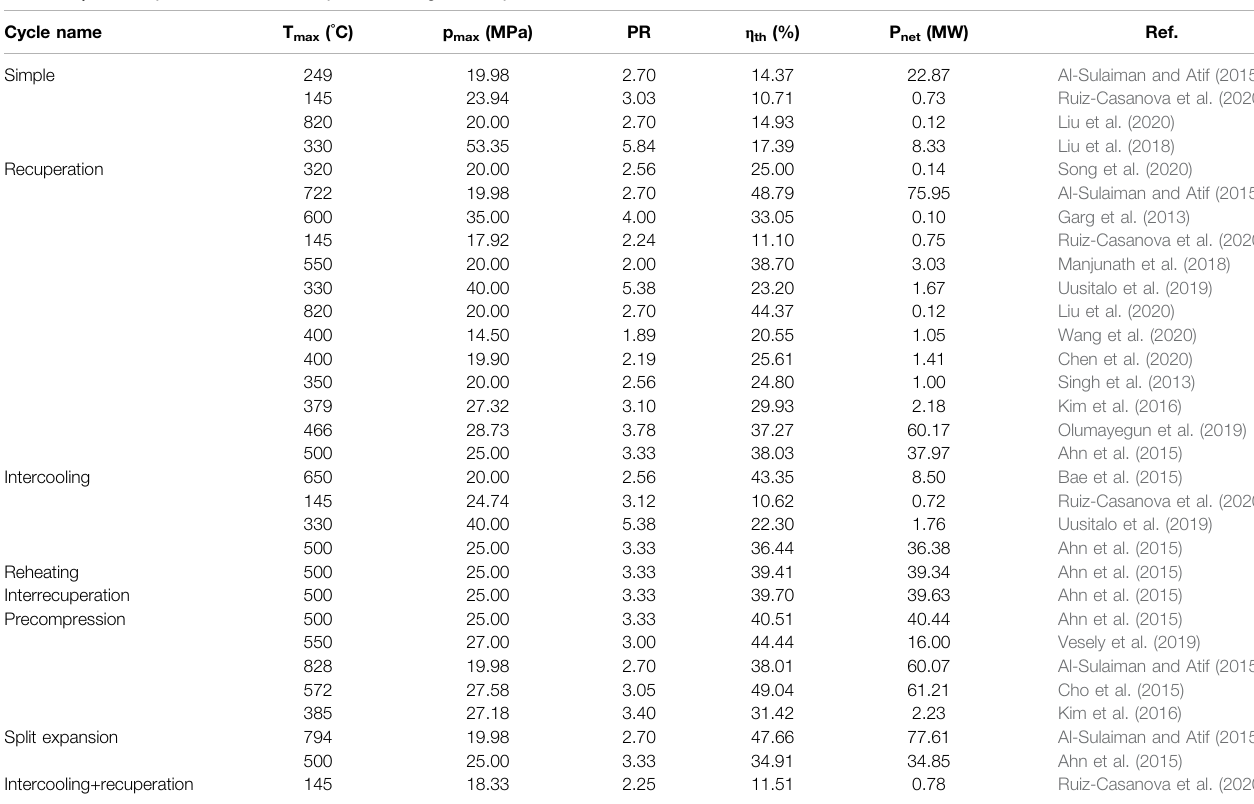
TABLE 2 | Boundary conditions of sCO 2 cycles with single- fl ow